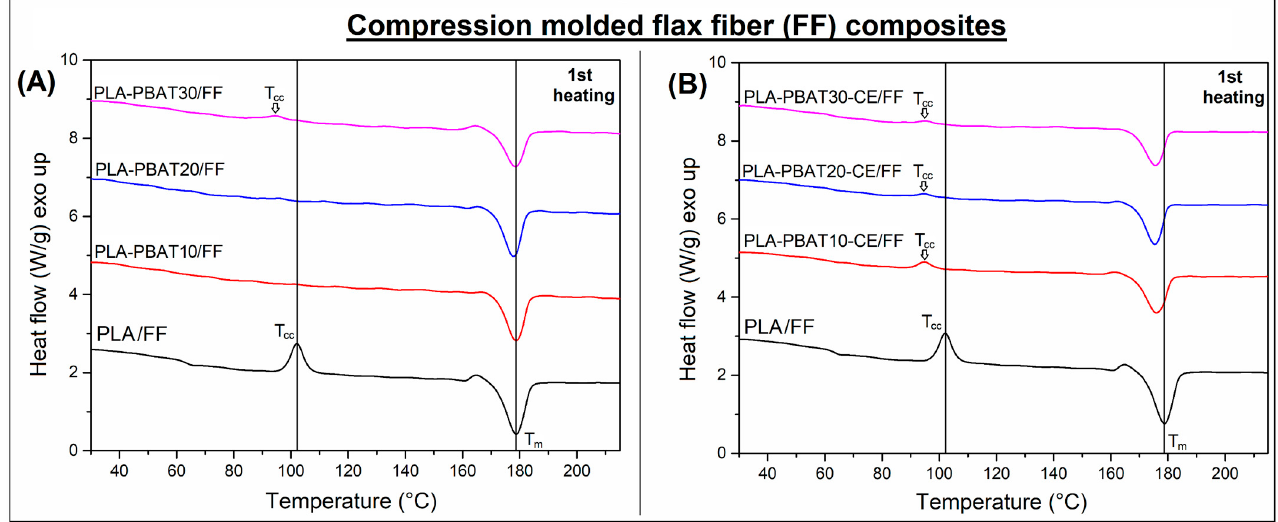
Figure 2. DSC thermograms for compression molded composites. The first heating thermograms for ( A ) unmodified PLA-PBAT/FF materials and ( B ) similar composites prepared with addition of CE. Table 2. The basic thermal properties for injection molded and compression molded samples. Matrix